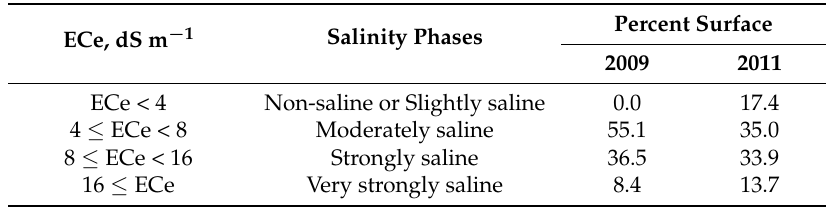
Table 3. Salinity phases for soils, derived from Soil Survey Division Staff [57], and their percent extent in the two years